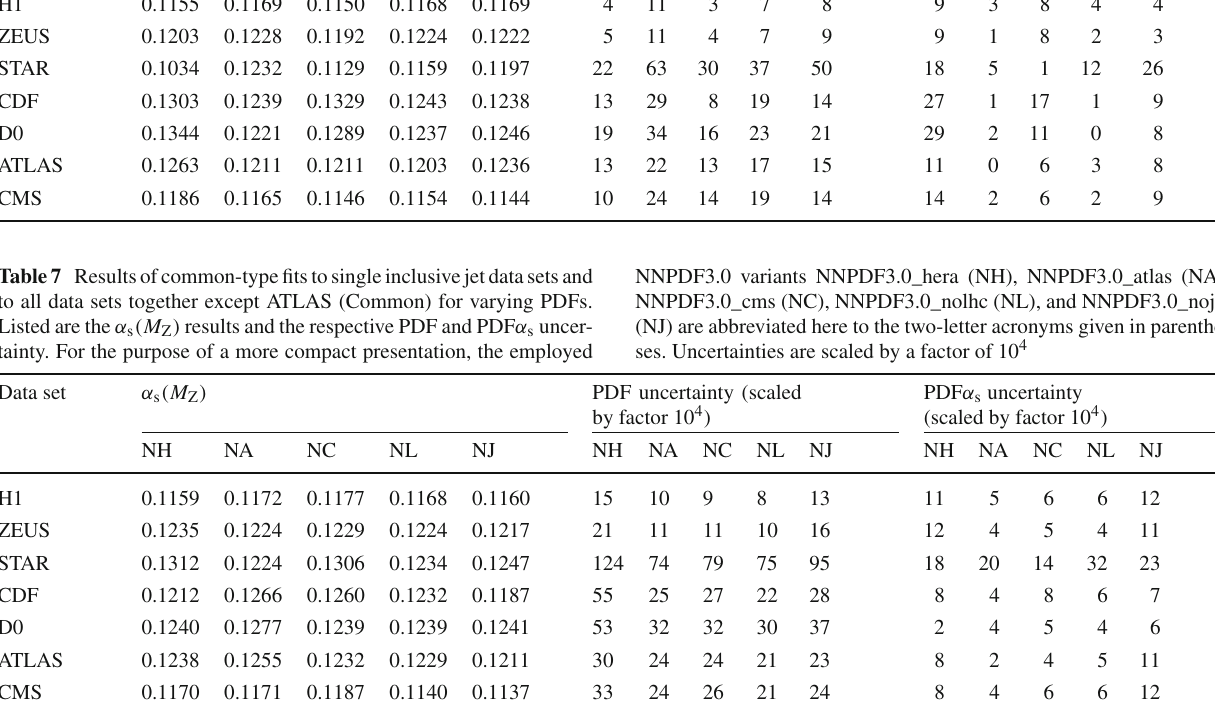
(H2), MMHT2014 (MM), and NNPDF3.0 (NN) are abbreviated here to thetwo-letteracronymsgiveninparentheses.TheresultsforNNPDF3.0 are listed for completeness and are identical to the ones displayed in Table 5. Uncertainties are scaled by a factor of 10 4